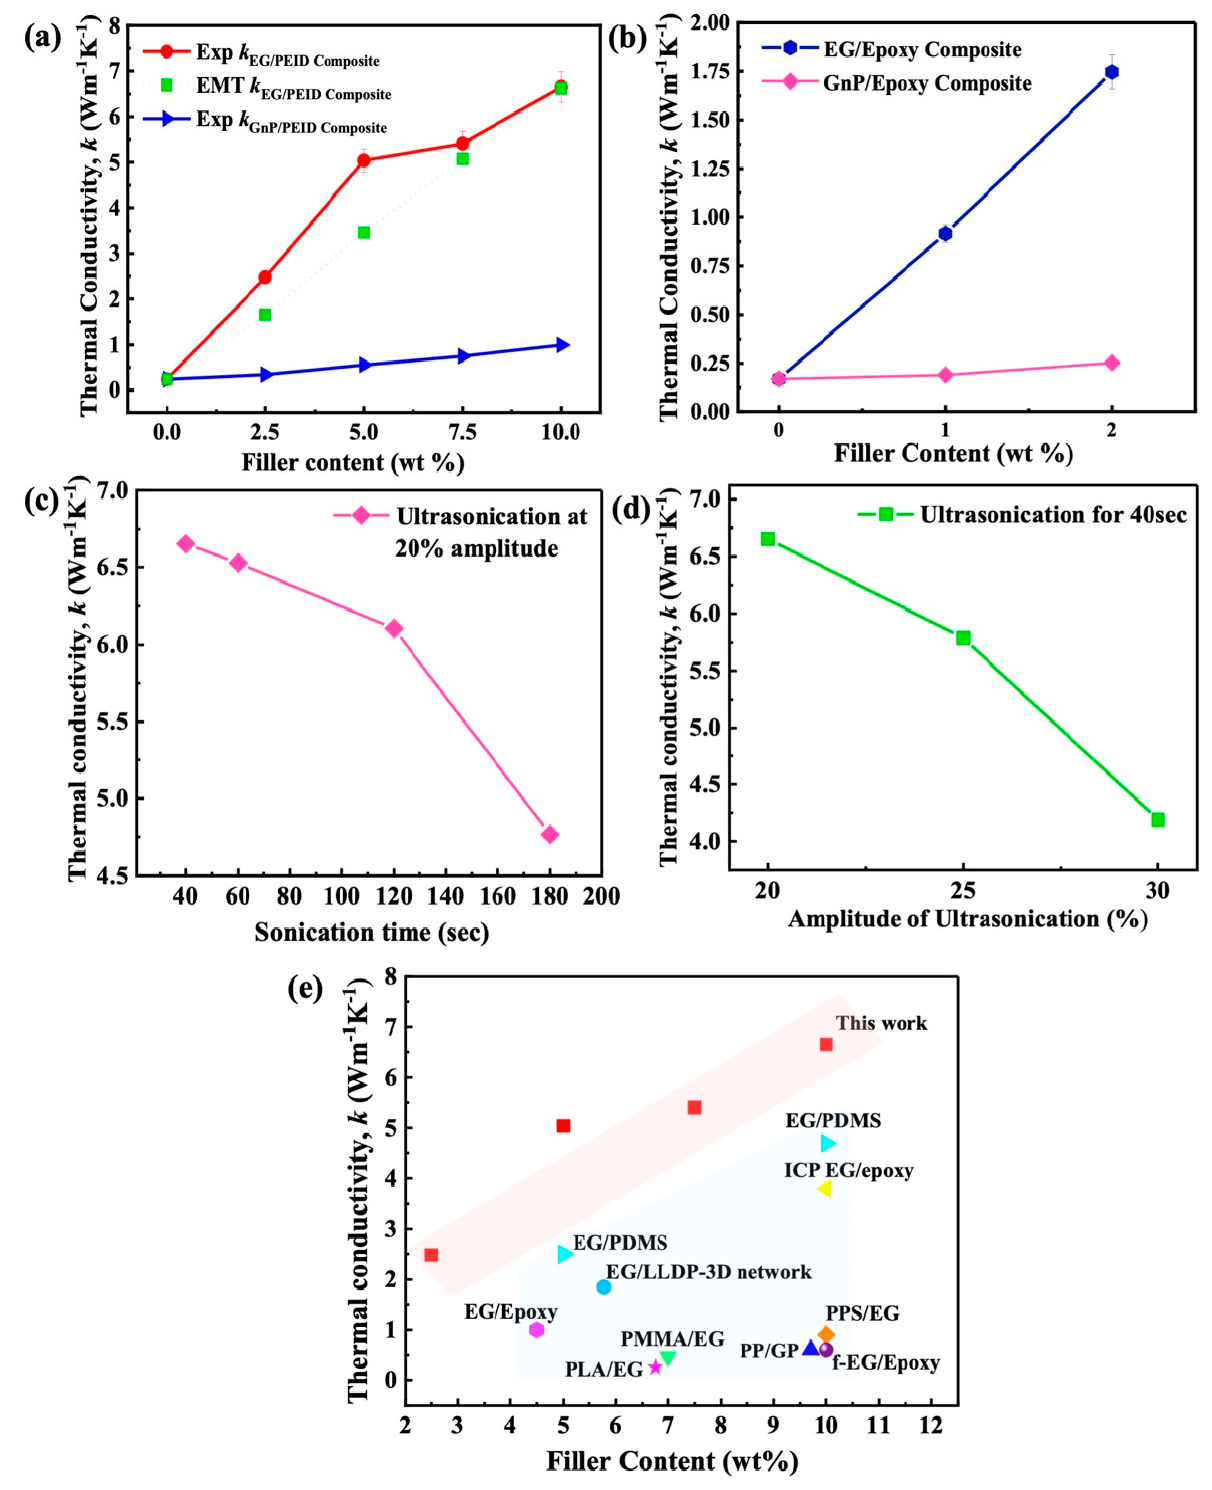
Figure 3. ( a ) Thermal conductivity value of EG/PEID (experimental and effective medium theory (EMT)) and GnP/PEID composite with different filler content (2.5, 5, 7.5, and 10 wt%), ( b ) thermal conductivity value of EG/epoxy composite with different filler content (0.5, 1, 1.5, and 2 wt%); ( c ) k value of EG/PEID composite with different sonication time at 20% ultrasonication power; ( d ) k value of EG/PEID composite with different ultrasonication power sonication for 40 s; ( e ) comparison of thermal conductivity value of polymer composites in previous works.